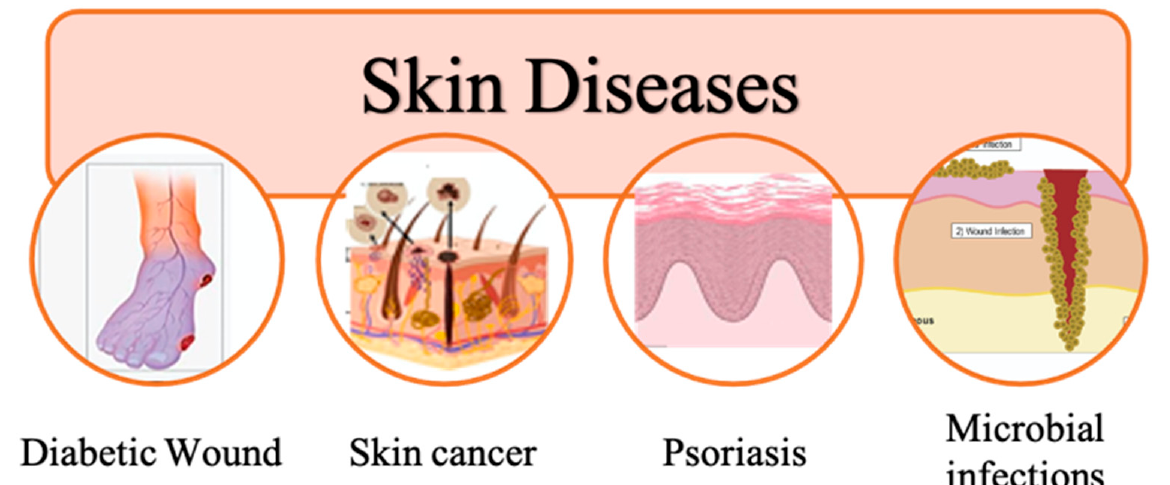
Figure 4. Changes in the skin caused by some of the most common skin diseases in humans. Copy- right permission for reuse from the ref. [50–53].